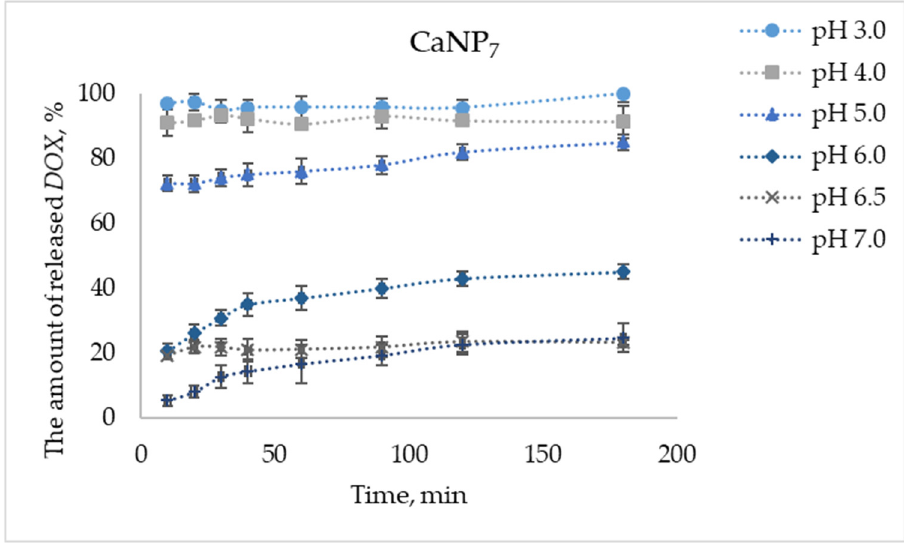
Figure 8. The proportion of DOX released from CaNP 7 – DOX with time at pH 3.0–7.0. High efficiency of a drug release at endosomal pH has been reported elsewhere [33].